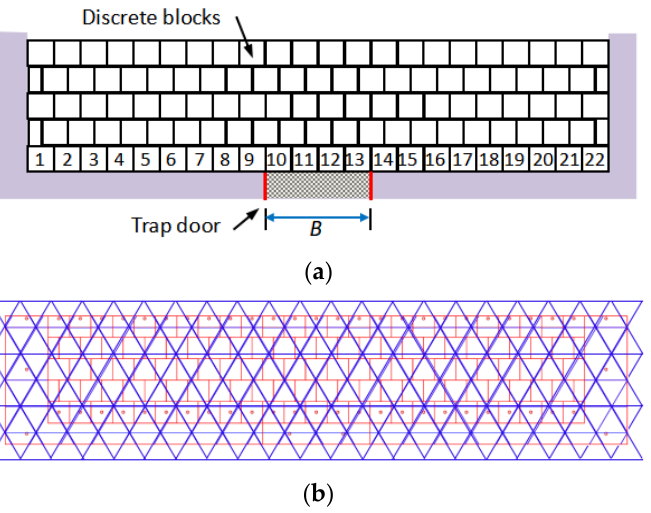
Figure 21. Block model for the simulations: ( a ) geometry of the model; ( b ) NMM mesh .